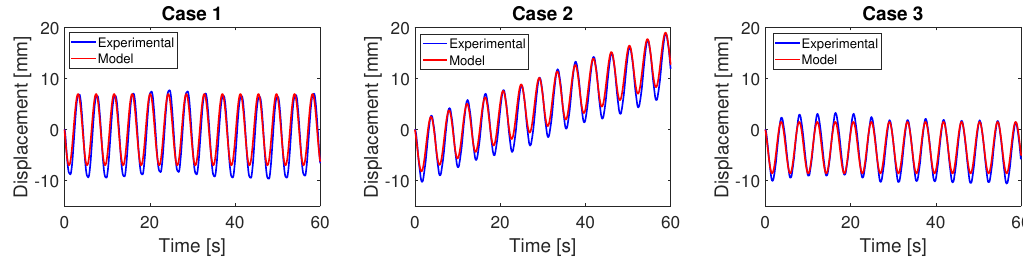
Figure 8. The theoretically predicted displacement of the robot compared with the experimentally measured data, obtained with the robot far away from the floor and